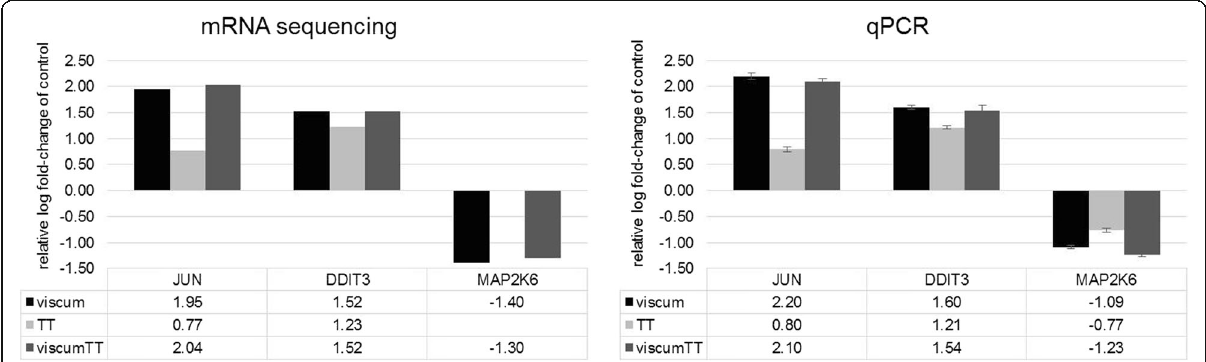
Fig. 2 ViscumTT alters the expression of genes involved in MAPK signalling. TC-71 cells were incubated for 24 h with viscumTT, viscum or TT in ~ IC50 concentrations. The changes in JUN , DDIT3 and MAP2K6 expression detected using mRNA sequencing were validated using qPCR. Gene expression relative to untreated control cells was calculated from qPCR data using the ΔΔ CT method. Bars represent the mean fold-change (log 10 ± SEM, error bars) in gene expression in treatment groups from four independent qPCR experiments and one mRNA sequencing